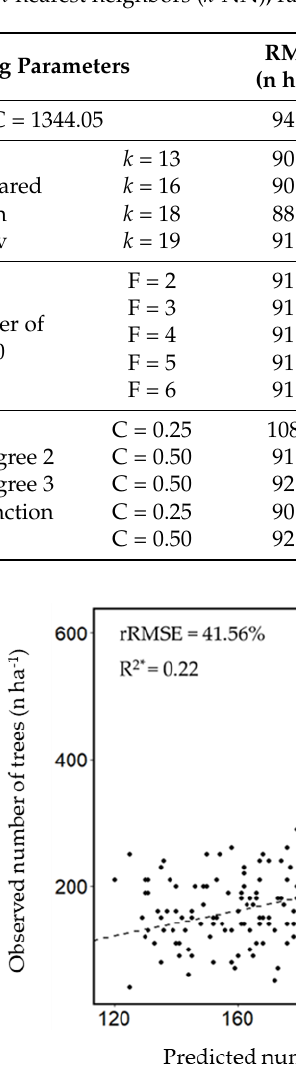
Table 5. Prediction accuracy of the number of trees ( N ) using multiple linear regression (MLR),